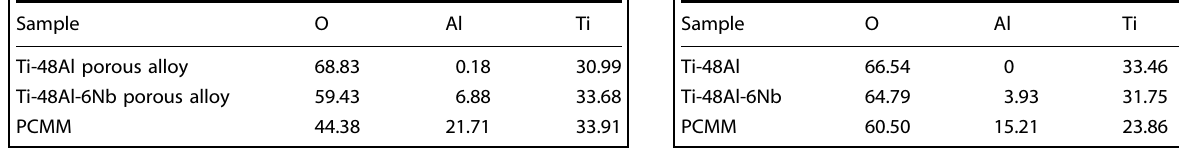
forming a hierarchical micro/nano-dual-scaled porous structure (Fig. 11 b). The PCMM with hierarchical micro/nano-dual-scaled porous structure by combining diffusion forming and chemical reaction forming technologies demonstrates potential for